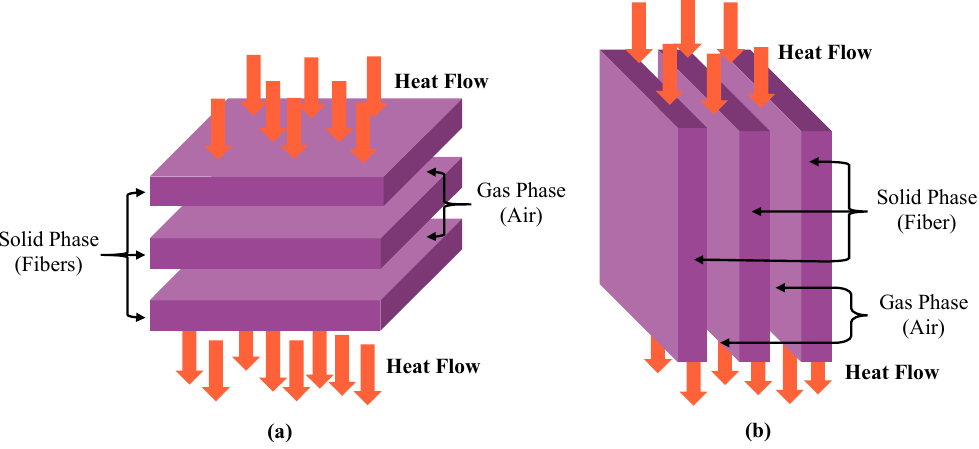
Figure 1. Fibers orientated perpendicular ( a ) or parallel ( b ) to the direction of heat flow.